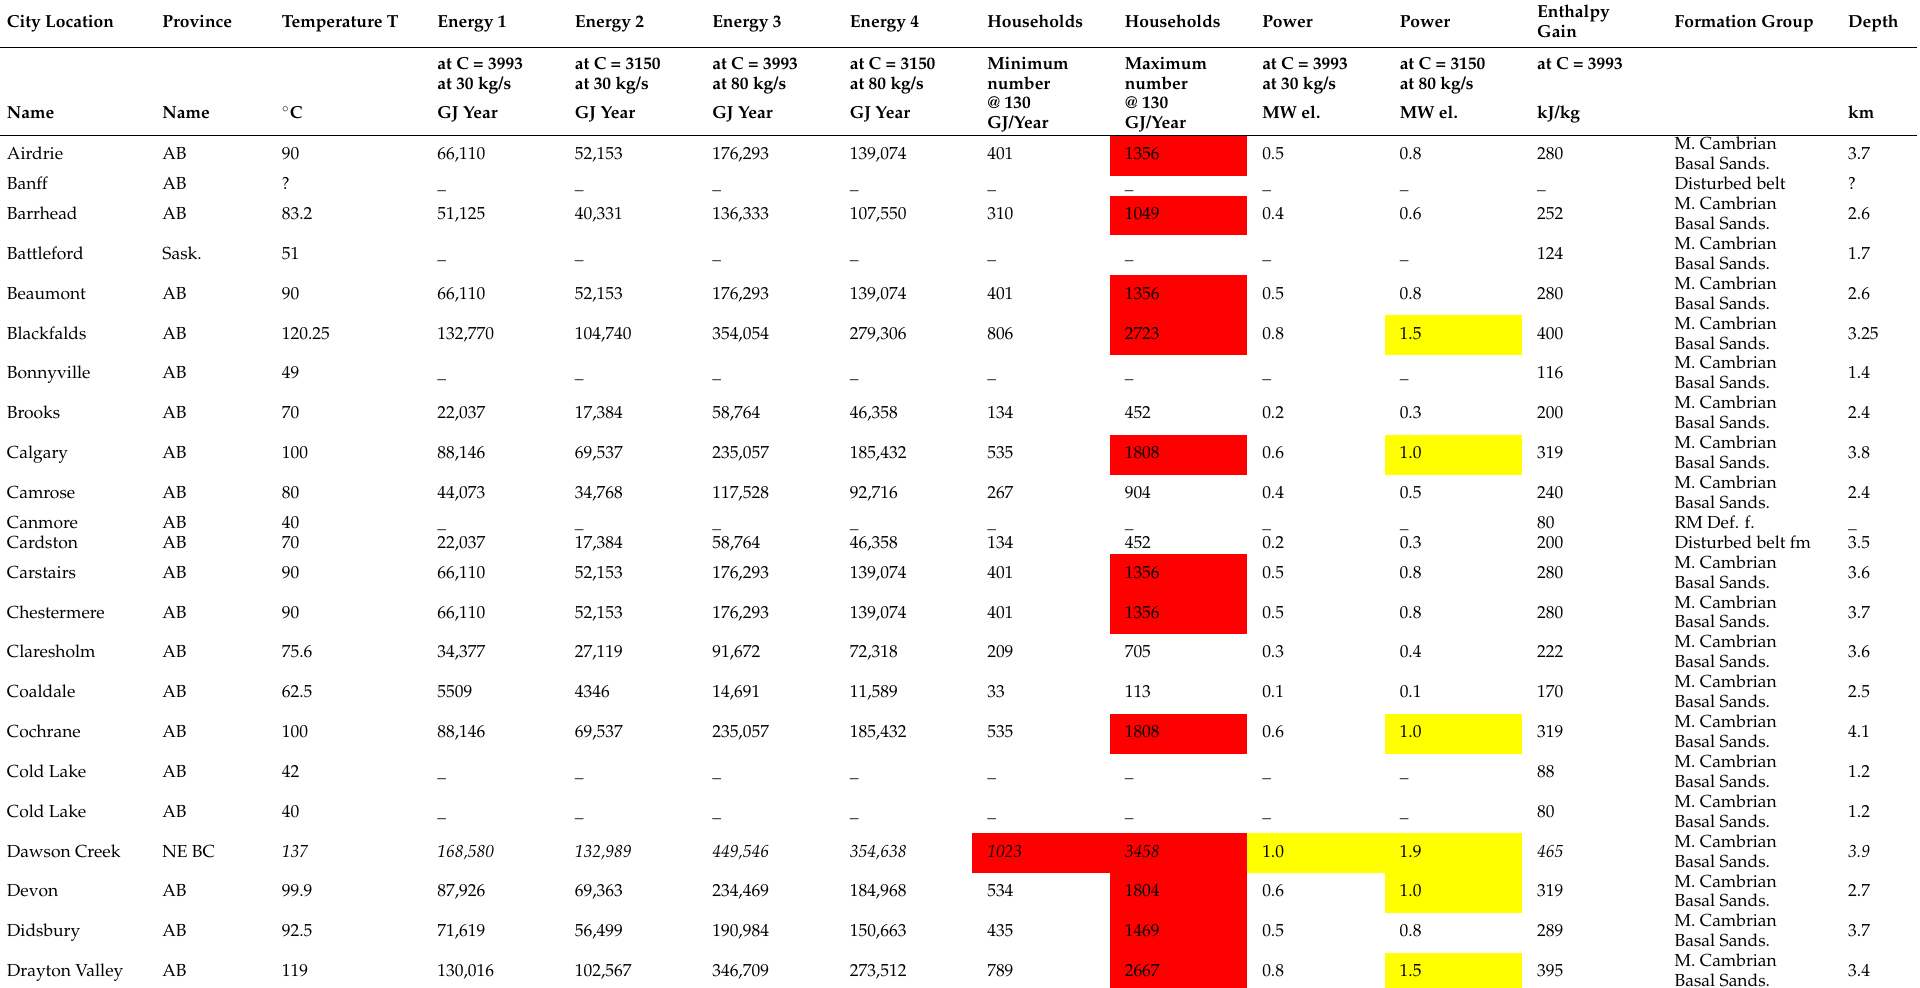
Table A1. WCSB >3 k populations centers geothermal prospects summary—Deepest basin above the crystalline basement—Energy, Enthalpy, Power, Number of direct geothermal heated Energy, Enthalpy, Power, No. of direct deep geothermal energy heated households